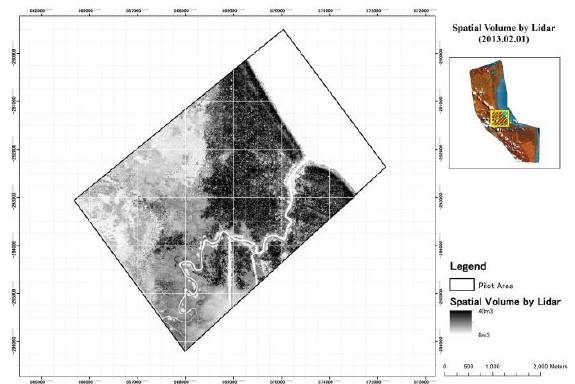
Figure 5. Distribution of spatial volume based on LiDAR